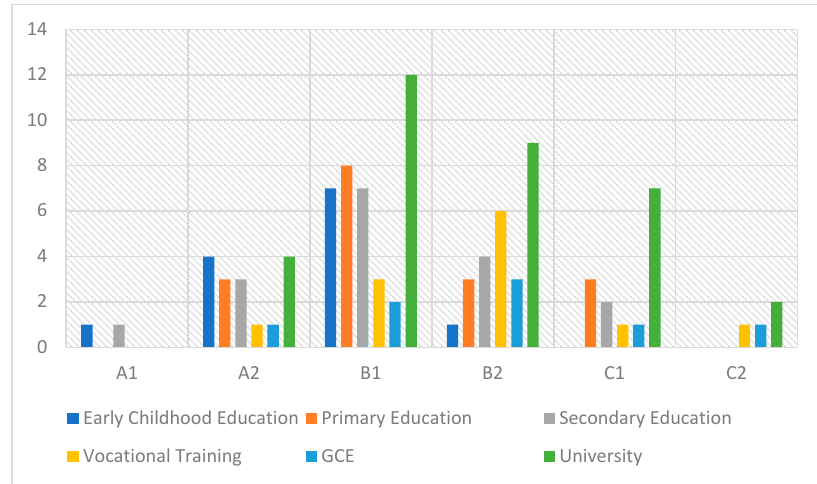
Figure 4. Level of Digital Competence by Stage.